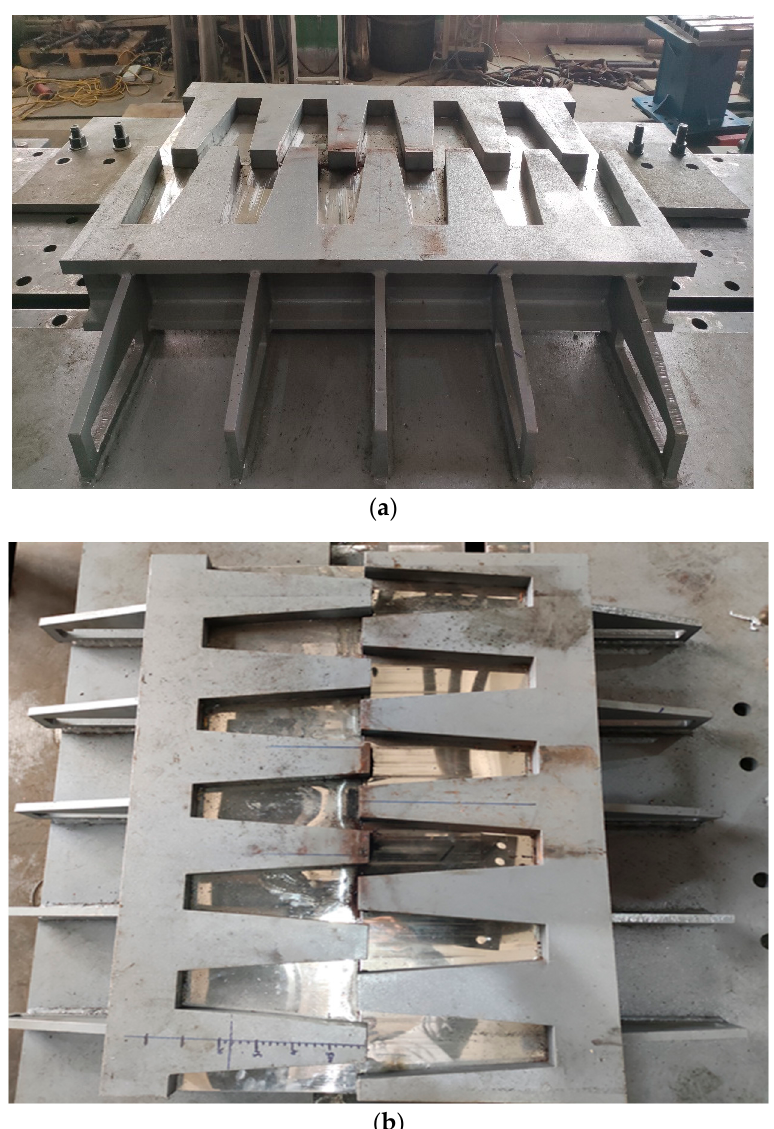
Figure 22. The comb plate expansion joint after fatigue test: ( a )The picture of the expansion joint from the main view, ( b ) The picture of the expansion joint from the top view.